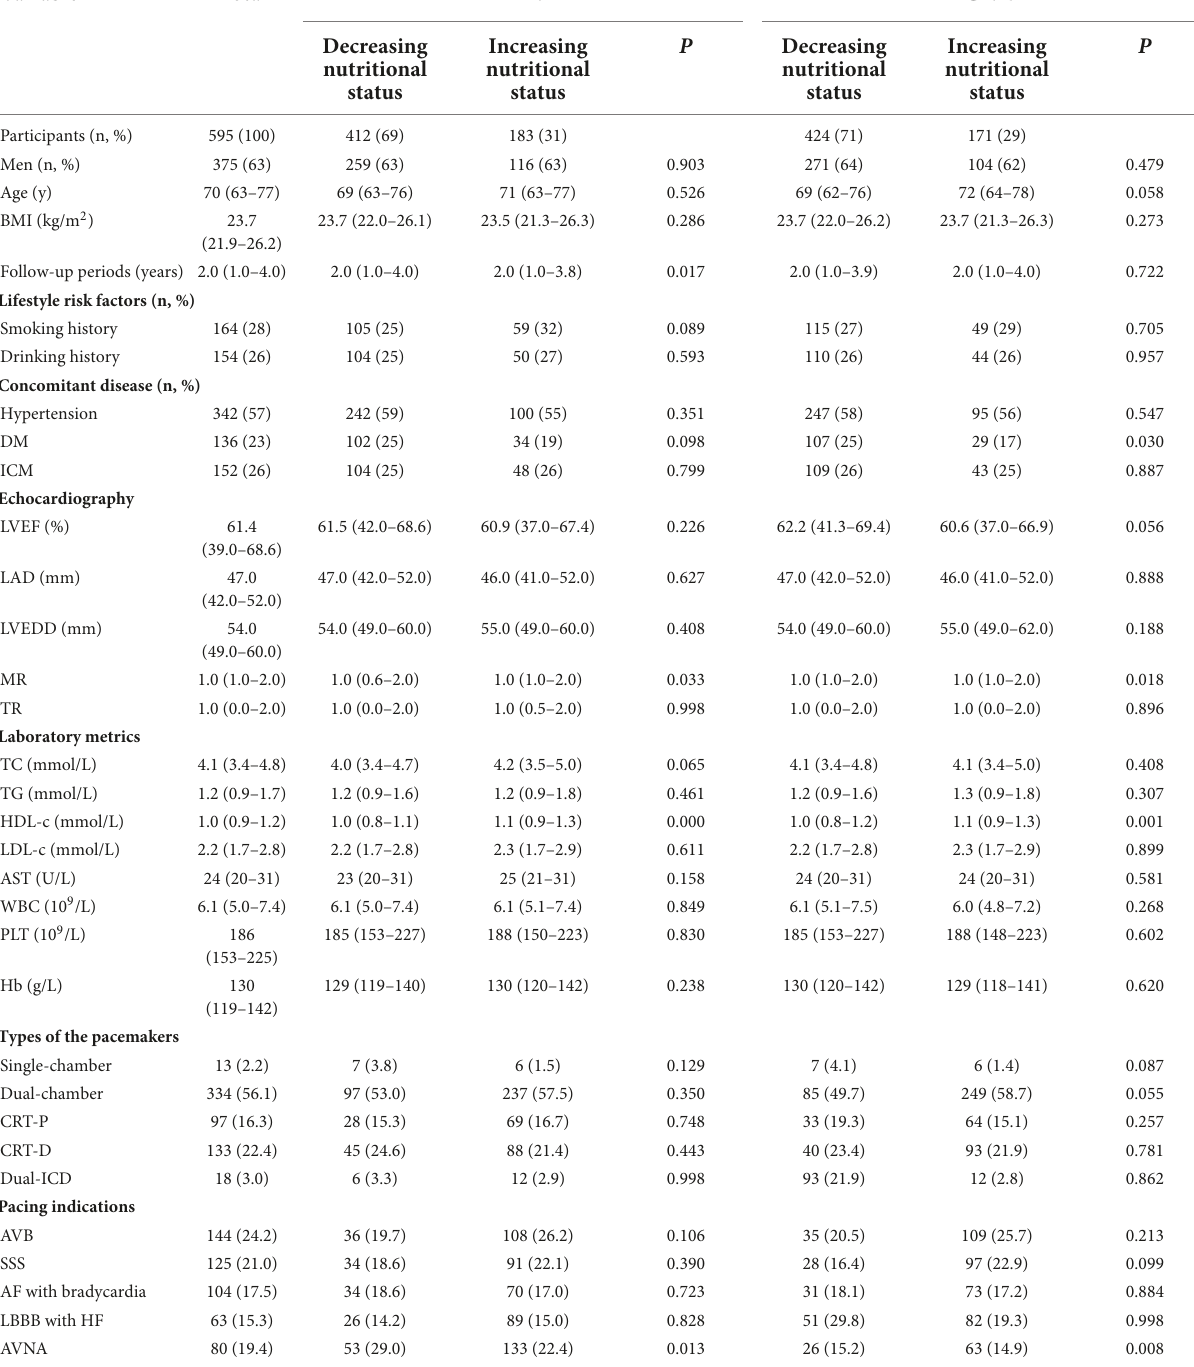
TABLE 1 Characteristics of the study